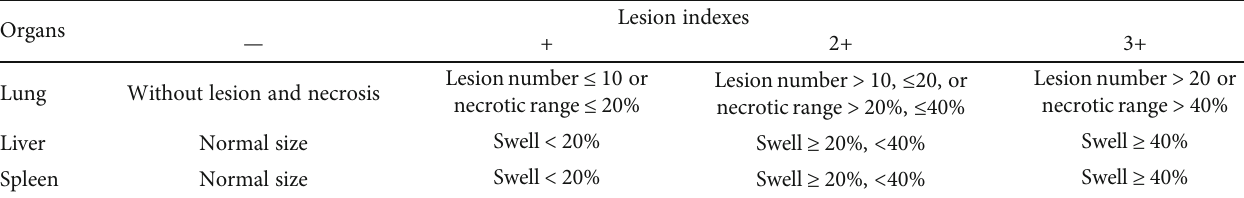
Table 2: The evaluation criteria for the gross pathological change of mouse organs.